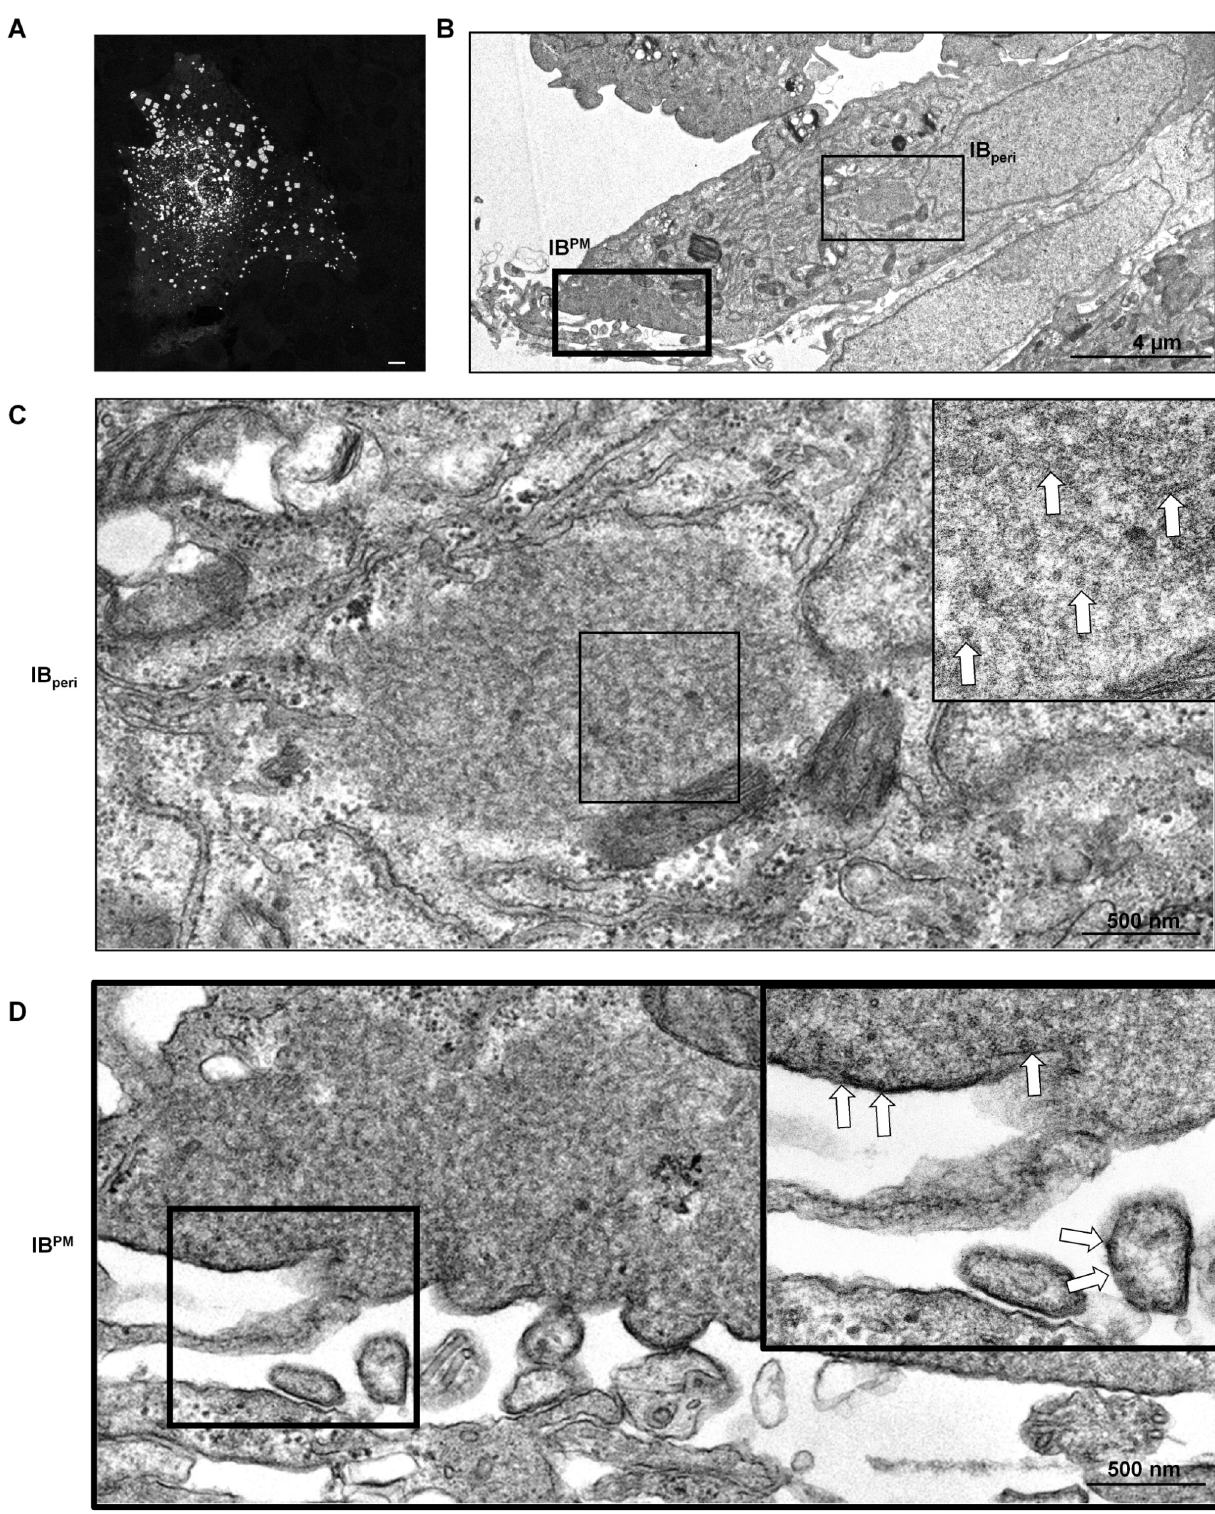
Fig 1. Inclusion bodies (IBs) in NiV-infected cells. (A) Vero76 cells were infected with wildtype NiV at a multiplicity of infection (MOI) of 0.05. At 24 h p.i. cells were fixed with 4% PFA for 48 h and permeabilized with Triton X-100. For staining of NiV IBs in syncytia, permeabilized cells were incubated with NiV N-specific antiserum. Scale bar, 10 μ m. (B-D) For ultrastructural analysis, cells were infected with NiV at a MOI of 2. Infected cells were fixed